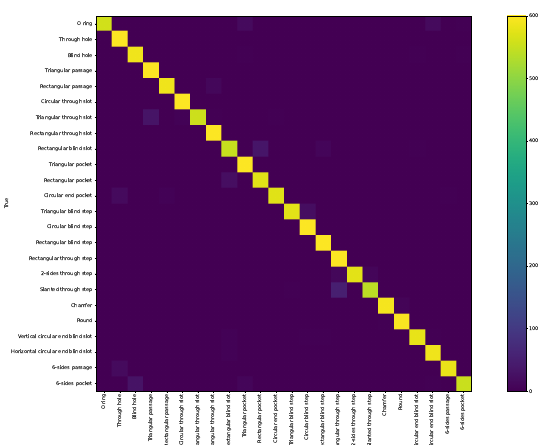
Figure A2. Confusion matrix for FeatureNetLite.